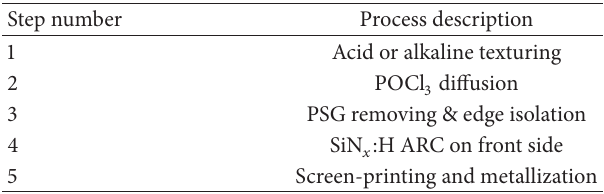
Table 1: Process sequence of Al-BSF solar cells.